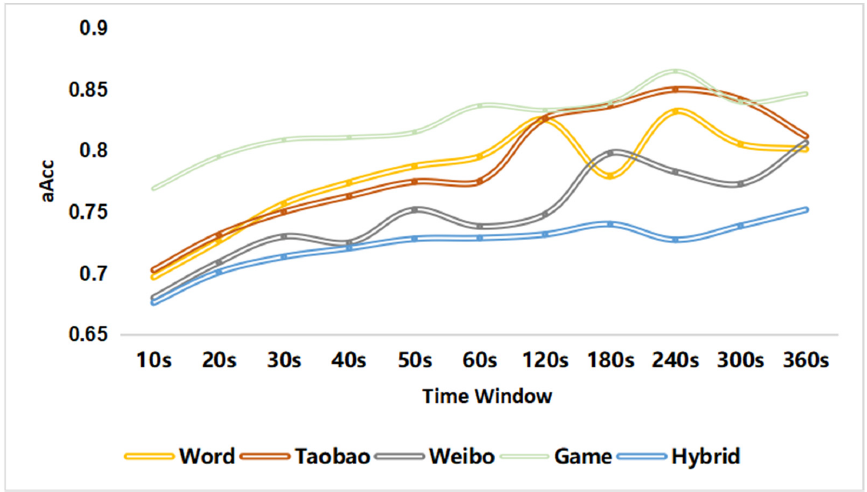
Figure 6. Comparing the user authentication accuracy of hybrid scenes and single scenes.